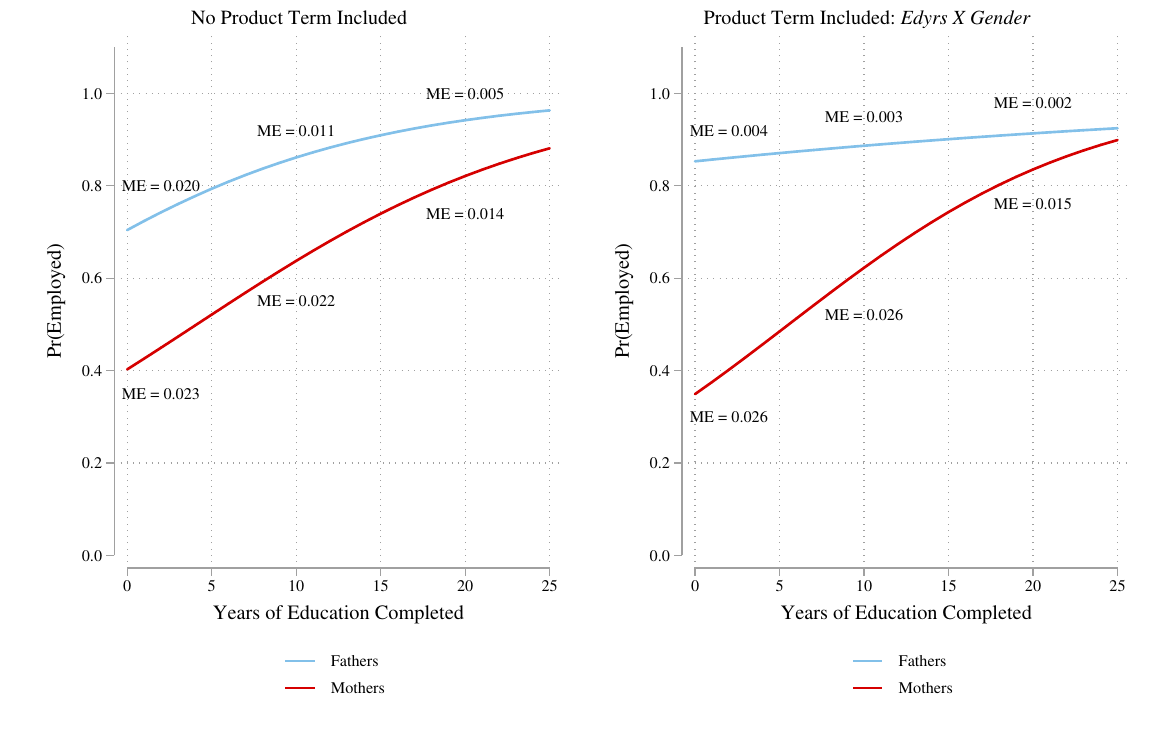
Figure 9: Effect of excluding a needed product term: interaction effect exists in the data-generating